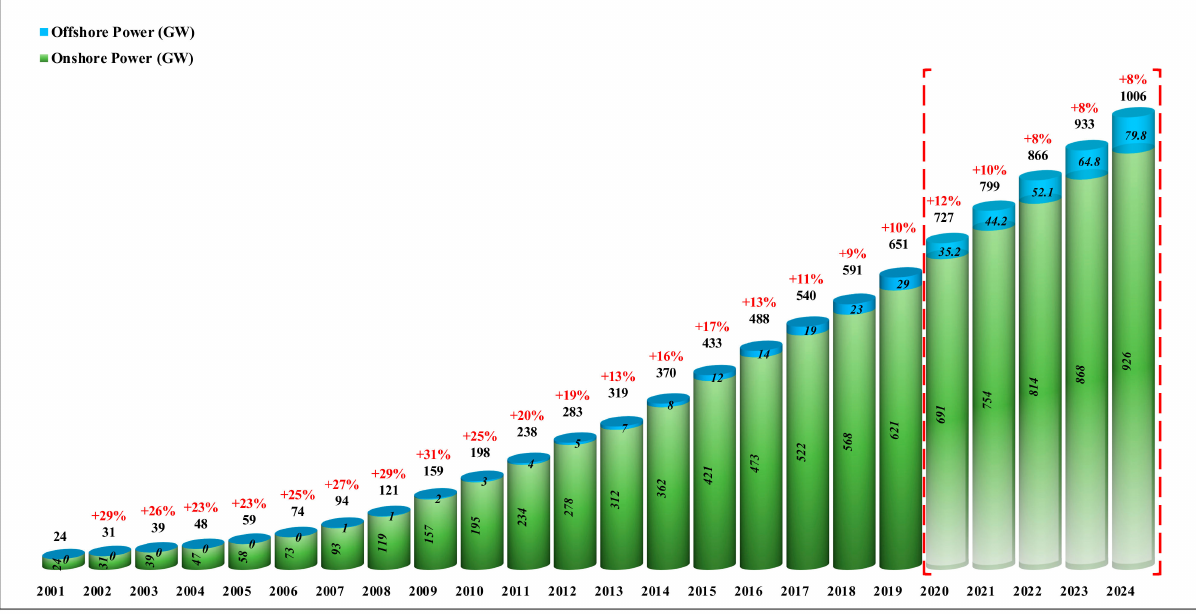
Figure 2. Five-year Global Wind Energy (GWE) capacity forecast. Offshore and Onshore terminologies refer to the installation of wind turbines in the water (ocean and sea), and on land,